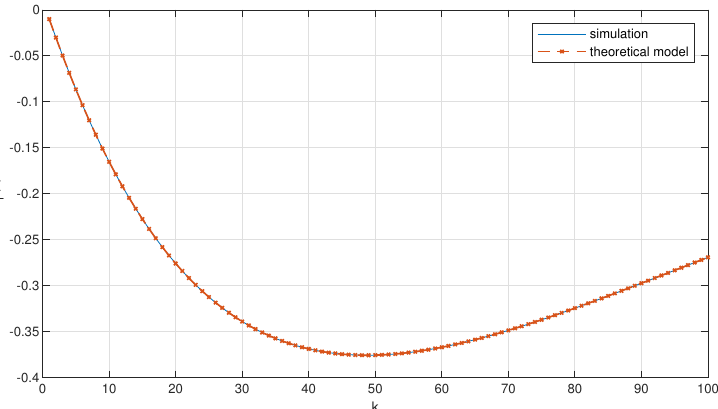
Figure 3. Distance error between leader and the first follower for a single